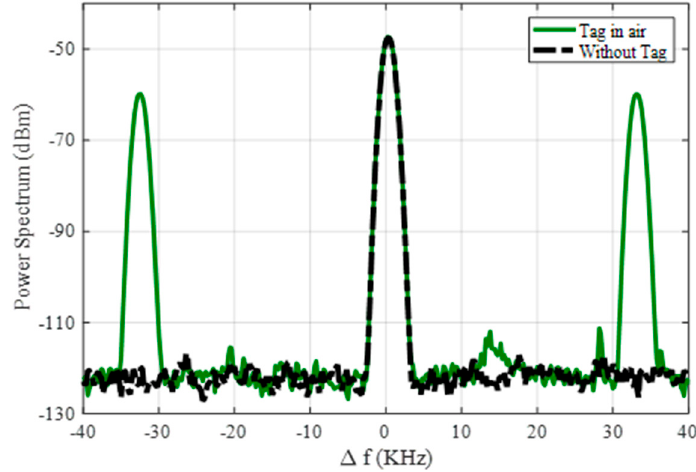
Figure 9. Measured spectrum at 2 f 0 = 1732 MHz ( ∆ f = 0) for two scenarios: without the tag and with the tag in the air at 0.7 m from the TX/RX antennas.